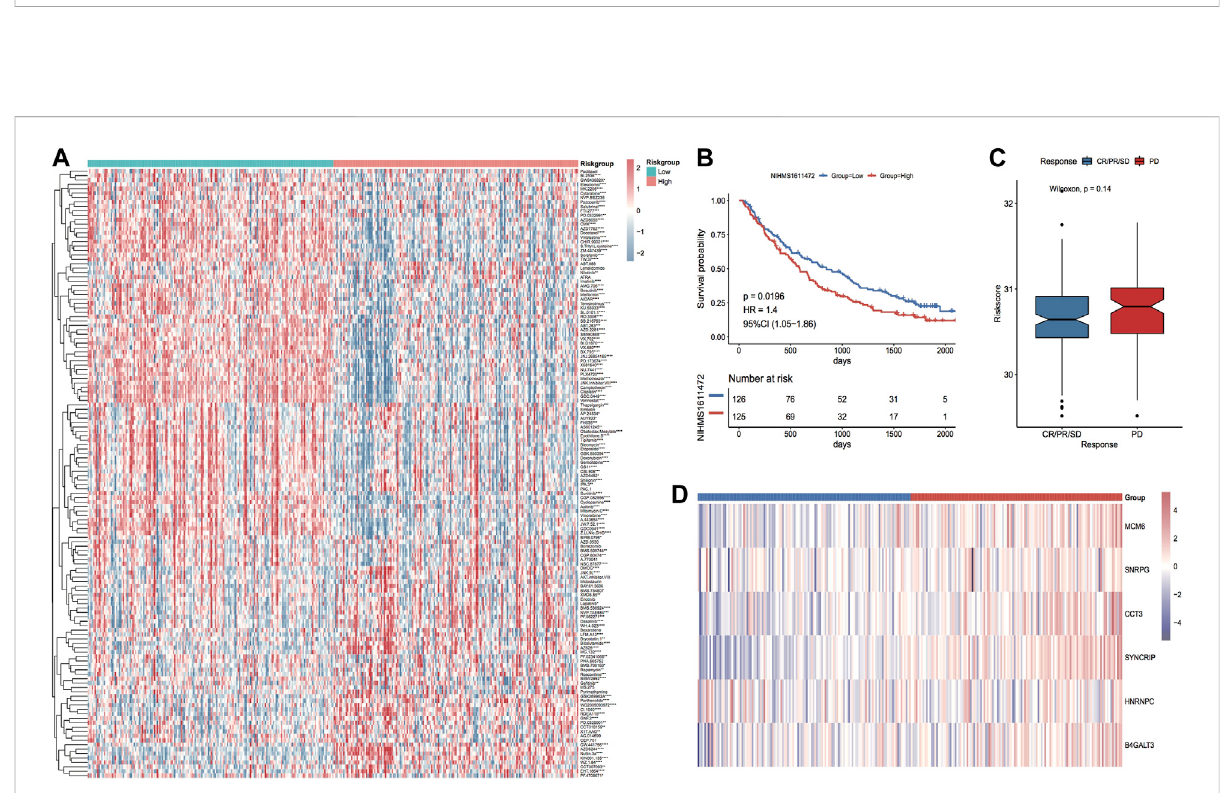
FIGURE 14 Enrichment analysis results of the HALLMARKER pathway. (A) Thermographic of correlation between Riskscore and HALLMARK pathway enrichment analysis, red highlights positive correlation, blue highlights negative correlation, shade represents high correlation, * sign represents signi fi cance; (B) thermographicofenrichmentscoreofHALLMARKpathway,*signrepresentstheenrichmentscoreofthispathwayinhighandlow- risk groups. Enrichment score difference signi fi cance.